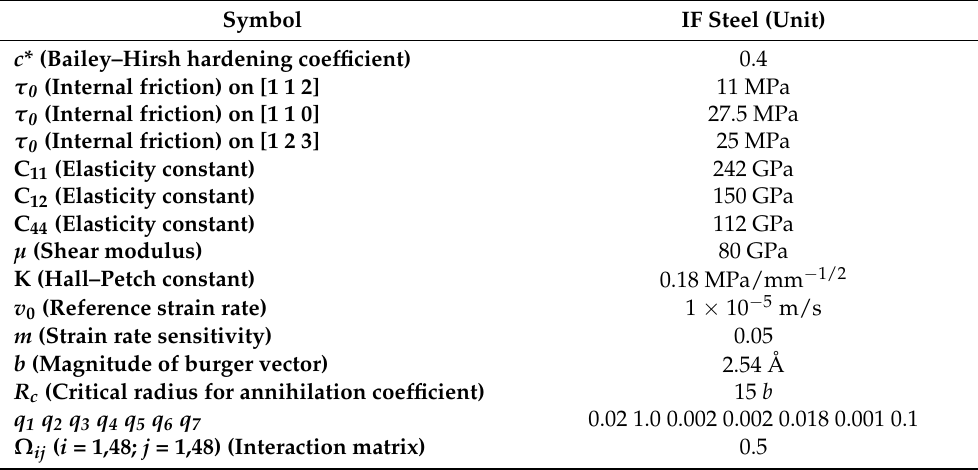
Table 1. Parameters used in the simulations. Symbol IF Steel